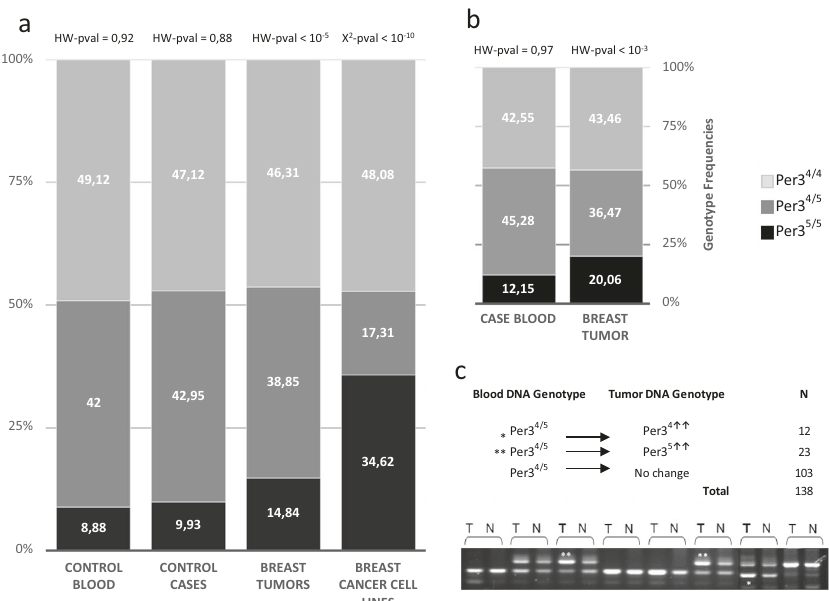
Fig. 2 PER3 VNTR genotype distribution in human samples. a PER3 VNTR genotype proportions in blood samples from control individuals in C1 and C2, blood samples from case individuals in C1 and C2, breast cancer tumor samples, and breast cancer cell lines. b PER3 VNTR genotype proportions of germinal (blood) and tumor samples of matched individuals. c Number of patients which presented heterozygous PER3 VNTR genotypes in blood samples (N) and homozygous PER3 VNTR genotypes in tumor samples (T). The image show the PCR analysis of genomic DNA of PER3 VNTR genotypes from matched tumor (T) and blood (N) samples of different